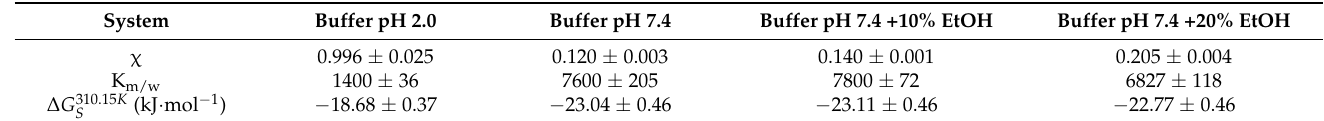
Table 1. Solubilizing capacity ( χ ), apparent micelle–water partition coefficients (K m/w ) and the free energy of solubilization ( ∆ G 0 ) in the systems of UMF with F-127 in the solutions of pH 2.0 and pH S 7.4 at 310.15